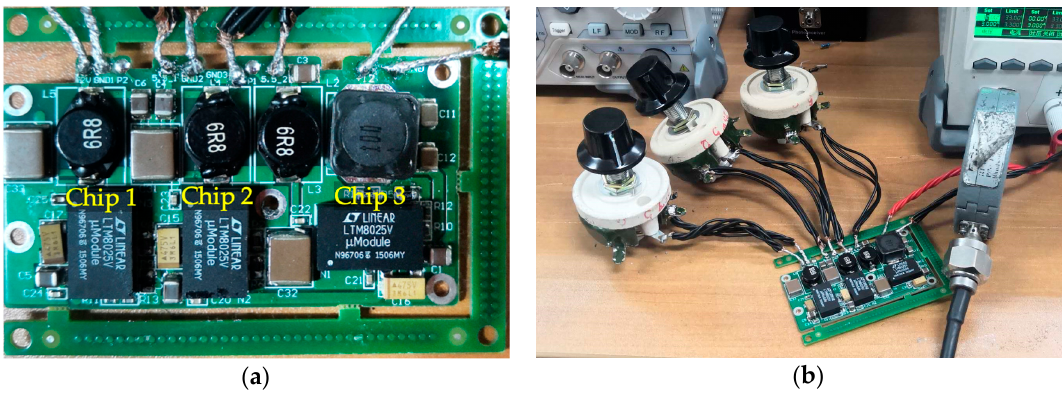
Figure 16. Photos of the power supply module instance. ( a ) PCB and its layouts; ( b ) Experimental scenario